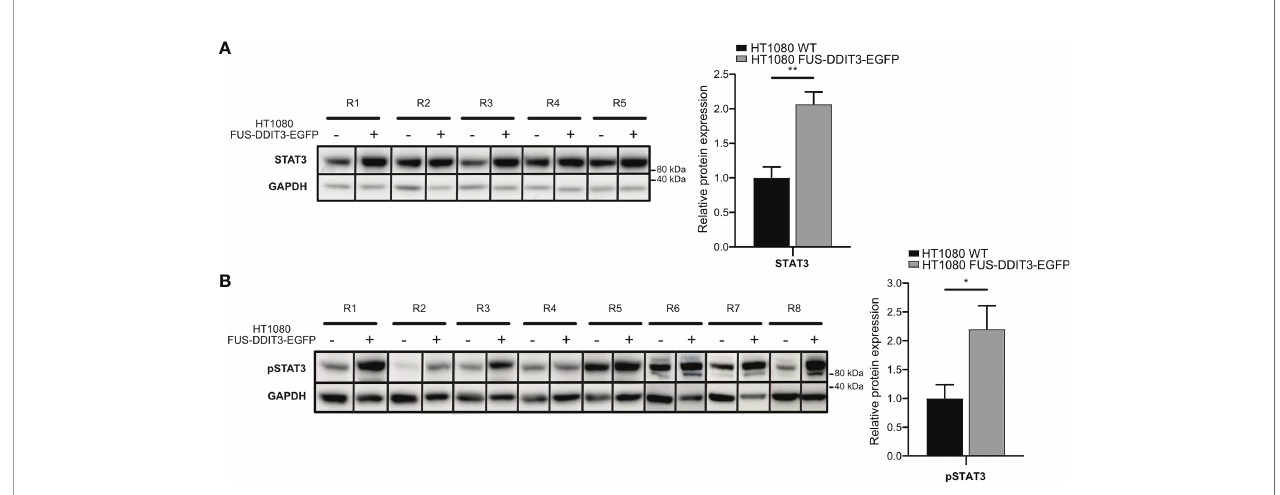
FIGURE 1 | FUS-DDIT3-induced STAT3 expression. (A) Western blot analysis of STAT3 using GAPDH as loading control in HT1080 cells with and without FUS-DDIT3 expression [HT1080 FUS-DDIT3-EGFP and HT1080 wild-type (WT), respectively]. Left panel: R1 – R5 correspond to samples collected at the same time for both cell lines in different cell passages. Right panel: Relative protein expression of STAT3 normalized to GAPDH. Expression values were mean-centered in relation to HT1080 WT samples. Mean ± SEM is shown, n = 5. ** p ≤ 0.01, unpaired Student ’ s t -test. Complete Western blot membranes are shown in Supplementary Figure 2 . (B) Western blot analysis of phosphorylated STAT3 (pSTAT3) using GAPDH as loading control in HT1080 cells with and without FUS-DDIT3 expression (HT1080 FUS-DDIT3-EGFP and HT1080 WT, respectively). Left panel: R1 – R8 correspond to samples collected at the same time for both cell lines in different cell passages. Right panel: Relative protein expression of pSTAT3 normalized to GAPDH. Expression values were mean-centered between Western blots in relation to HT1080 WT samples. Mean ± SEM is shown, n = 8. * p ≤ 0.05, unpaired Student ’ s t -test. Complete Western blot membranes are shown in Supplementary Figure 2